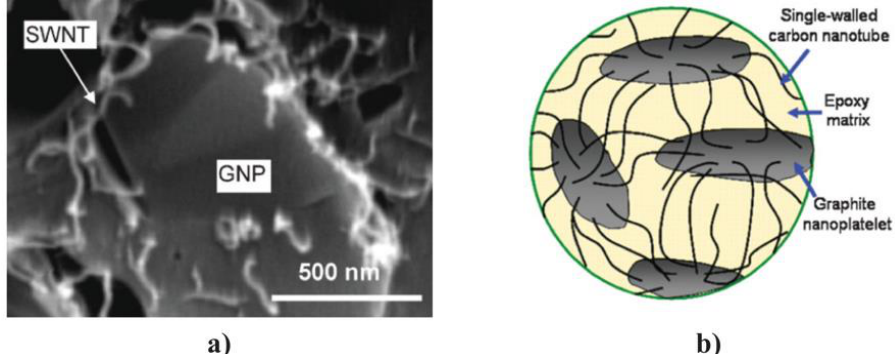
Figure 30. GNP/SWCNT/epoxy composite: ( a ) SEM image and ( b ) schematic representation of GNP-SWCNT network. SWCNTs bridge adjacent graphite nanoplatelets, and SWCNT ends are extended along nanoplatelet surfaces. Reprinted with permission from [89]. Copyright 2008 John Wiley and Sons.